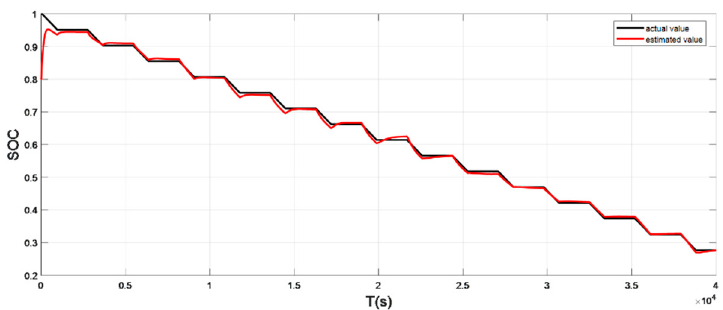
Figure 16. Comparison of the SOC real value and estimated value under constant current discharge (high temperature: 50 °C).